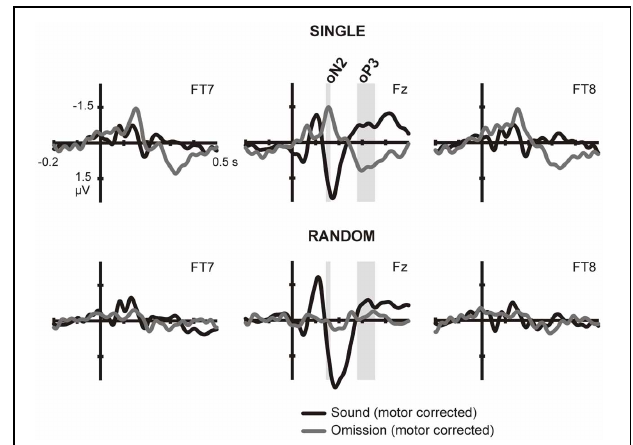
FIGURE 1 | ERPs in sound and omission trials. Sound and omission responses in the single sound (top) and random sound (bottom) conditions, plotted for one selected electrode in each ROI (temporal left: FT7, frontocental midline: Fz, temporal right: FT8). Both sound and omission responses are motor-corrected via subtraction of the no-sound motor control waveform. Clear omission-related responses are present only for omissions in the single sound condition and not for omissions in the random sound condition. The analysis time-windows for the oN2 (144–164 ms) and oP3 (278–356 ms) components are indicated with gray shading on the midline ROI